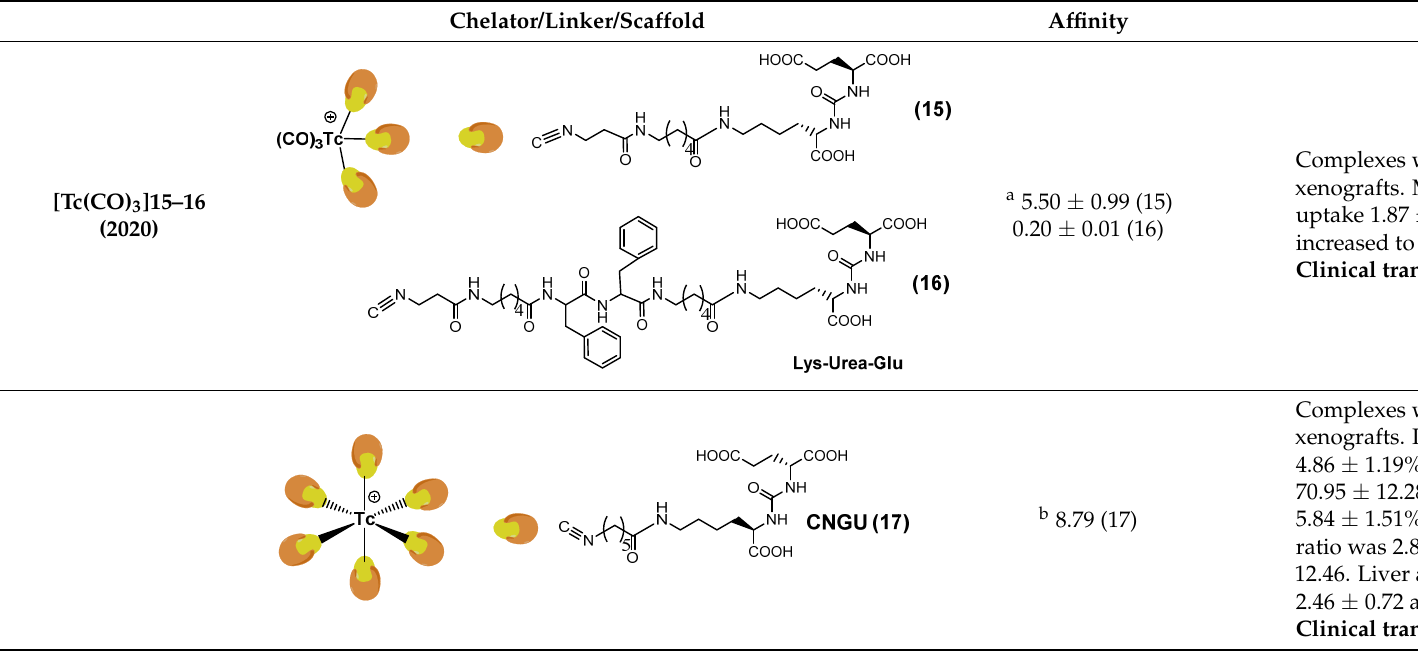
Table 4. PSMA-i labeled with [ 99m Tc][Tc(CO) 3 ] + -fragment in a multivalent approach.